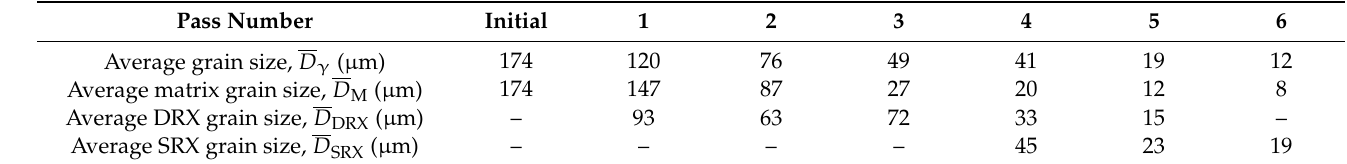
Table 4. Average grain size at the end of each interval.